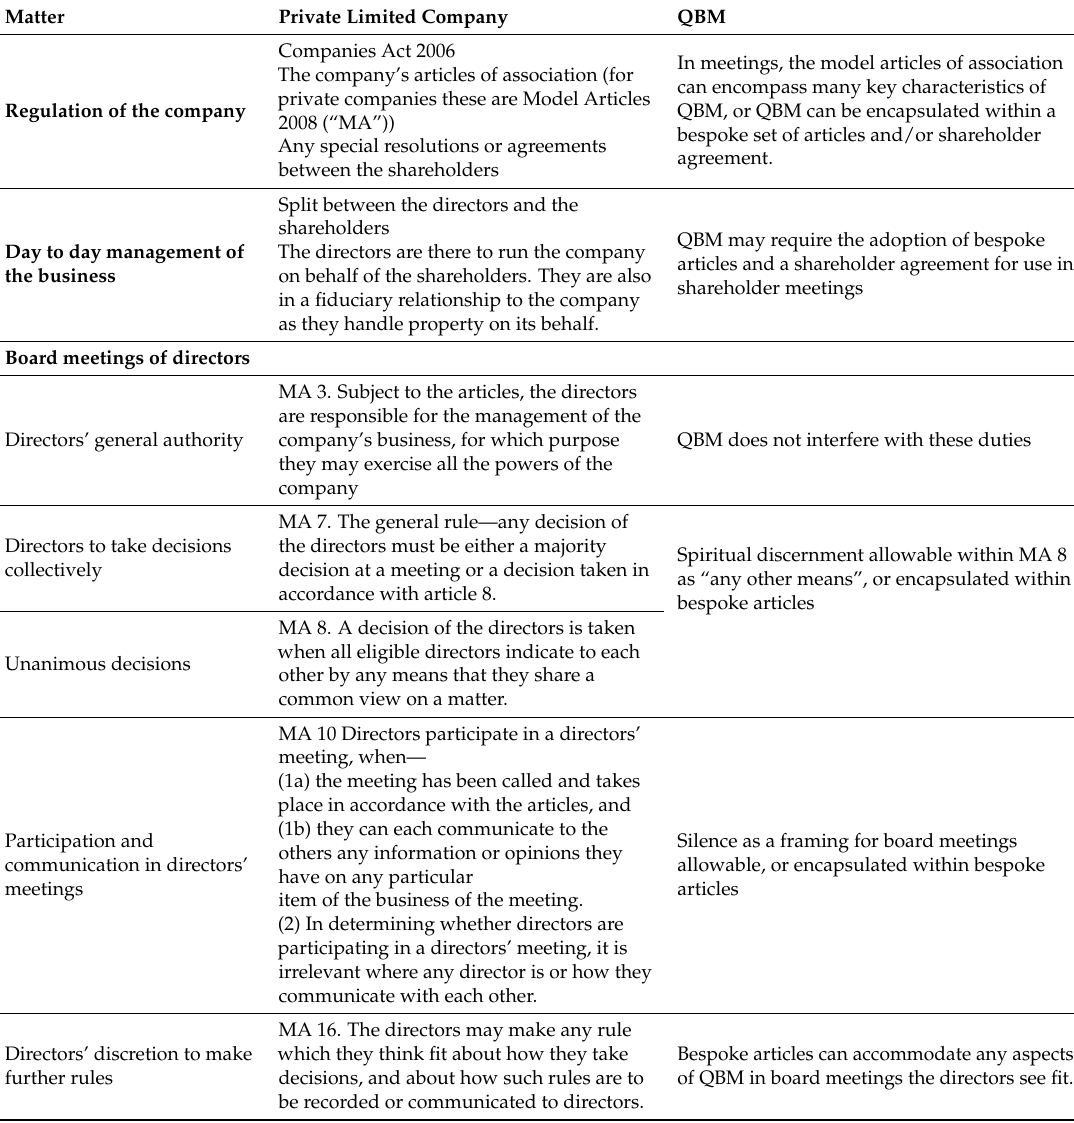
Table 1. Quaker spiritual practice and corporate